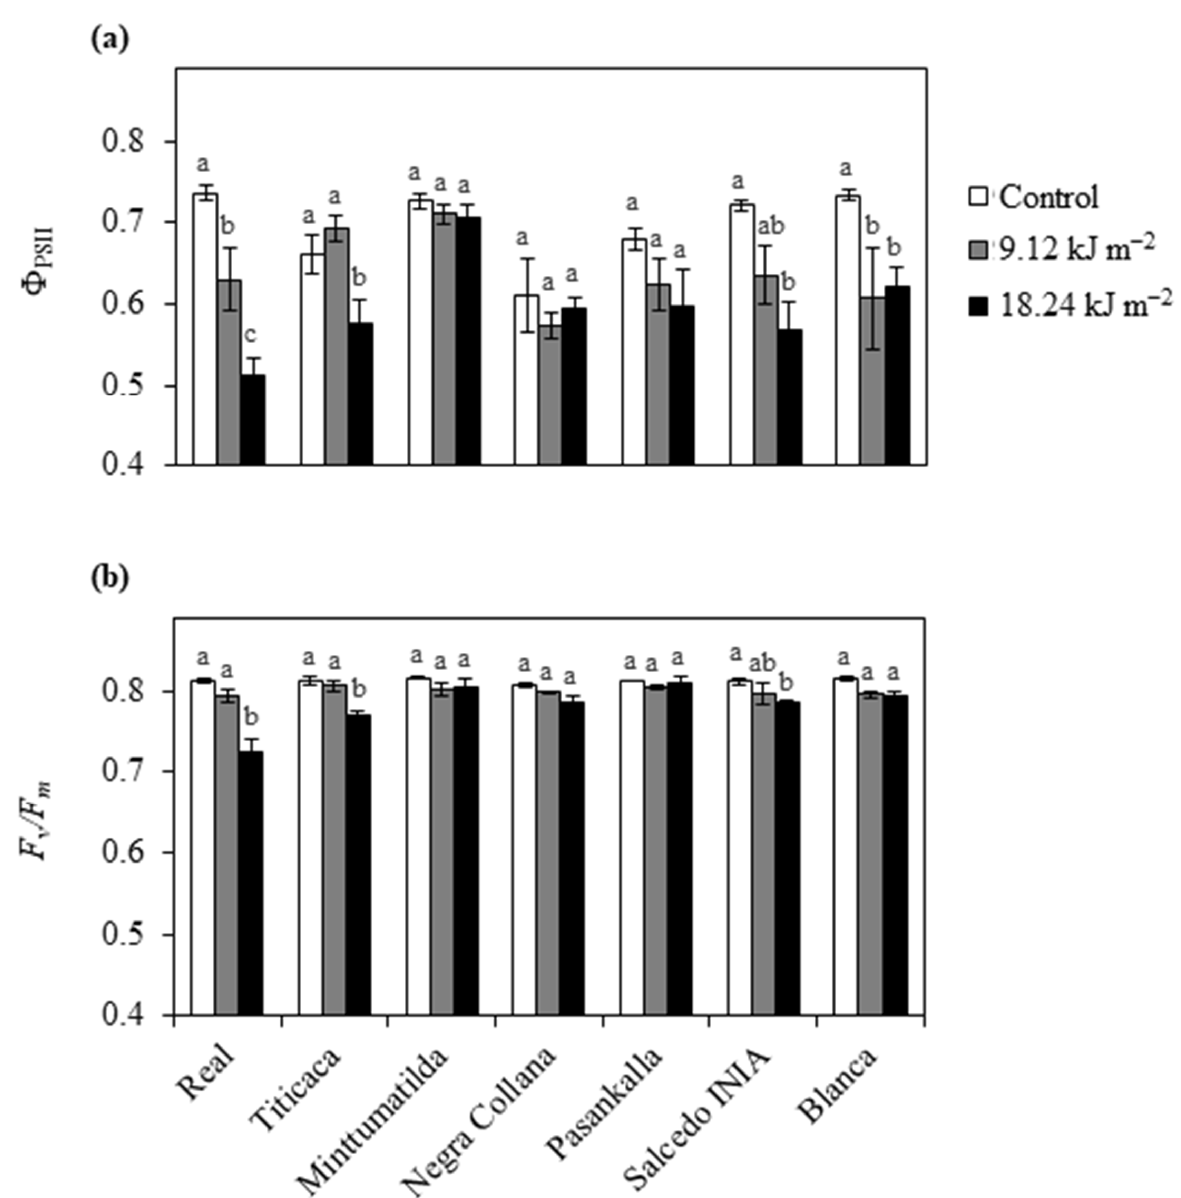
Figure 1. Effects of UV-B on the actual ( Φ PSII ) and maximum ( F v / F m ) efficiency of PSII photochemistry. Different quinoa varieties were exposed to 0 (Control), 9.12 and 18.24 kJ m − 2 UV-B. Parameters of Φ PSII ( a ) and F v /F m ( b ) were evaluated in leaves at 3 days of treatment. Error bars represent the standard error of the mean (n = 3). Different letters indicate significant differences between means within the same variety ( P < 0.05, Tukey’s test).